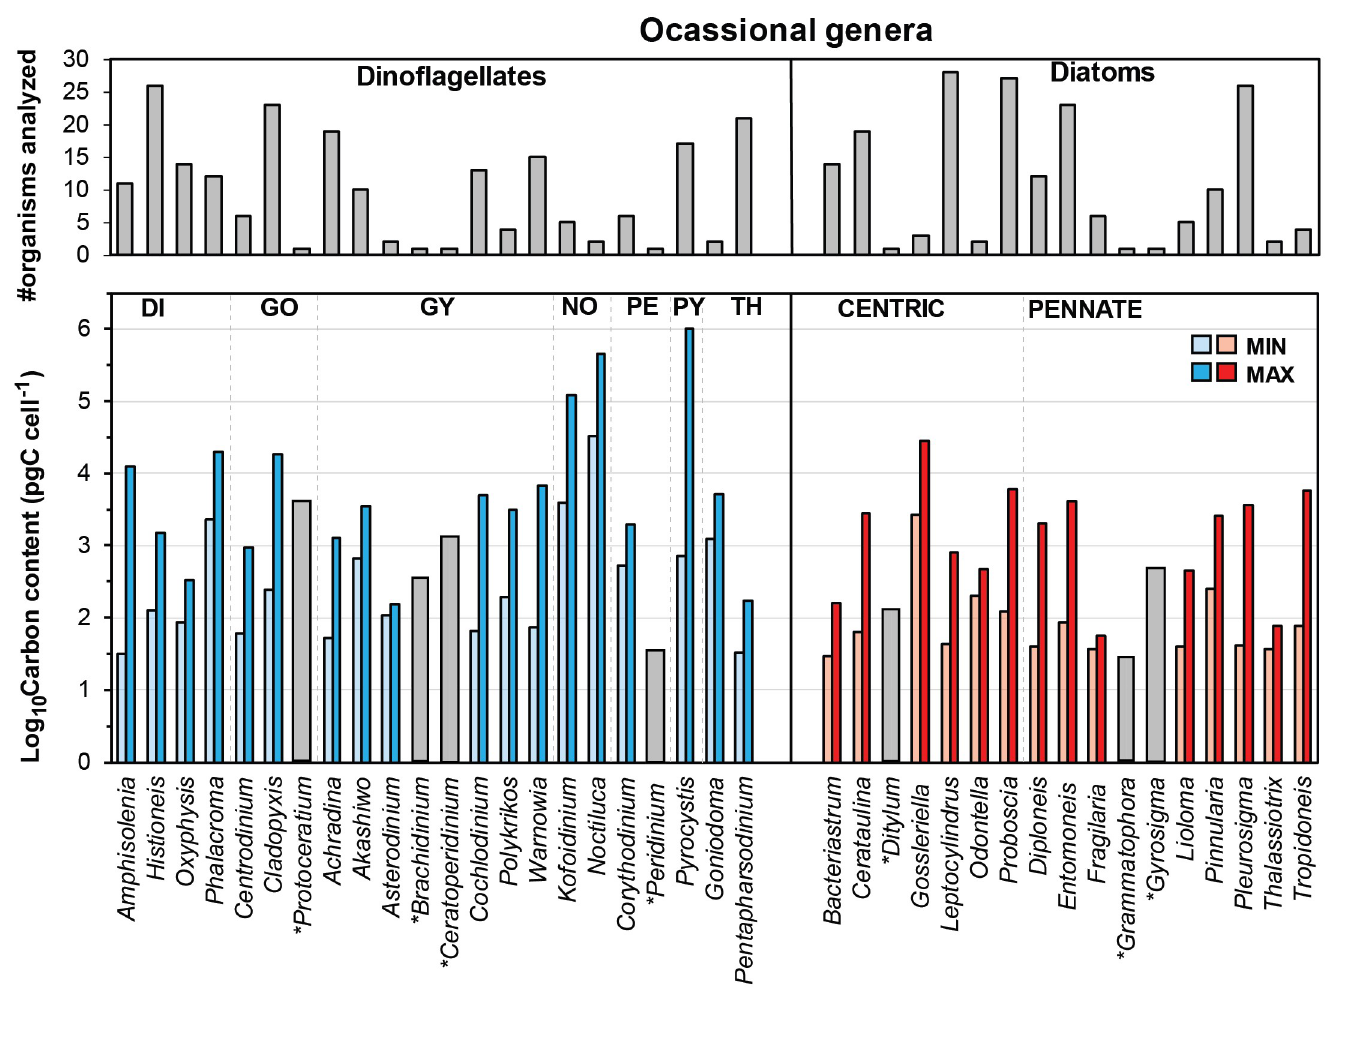
Fig 7. Logarithmic (Log 10 ) minimum and maximum values of carbon content (pg C cell -1 ) for ocassional genera. Minimum (light-colored bars) and maximum (dark-colored bars) log-values of carbon content (pg C cell -1 ; lower panels) for genera of dinoflagellates (blue bars) and diatoms (red bars) occasionally found in phytoplankton samples (i.e., < 30 cells per genus). Grey bars in the upper panels indicate the number of organisms analyzed per genus. Asterisks denote genera with only a single cell measurement for the carbon content estimation (grey bars in the lower panels). Dinoflagellate orders: DI, Dinophysales; GO, Gonyaulacales; GY, Gymnodiniales; NO, Noctilucales; PE, Peridiniales; PY, Pyrocystales; TH, Thoracosphaerales.